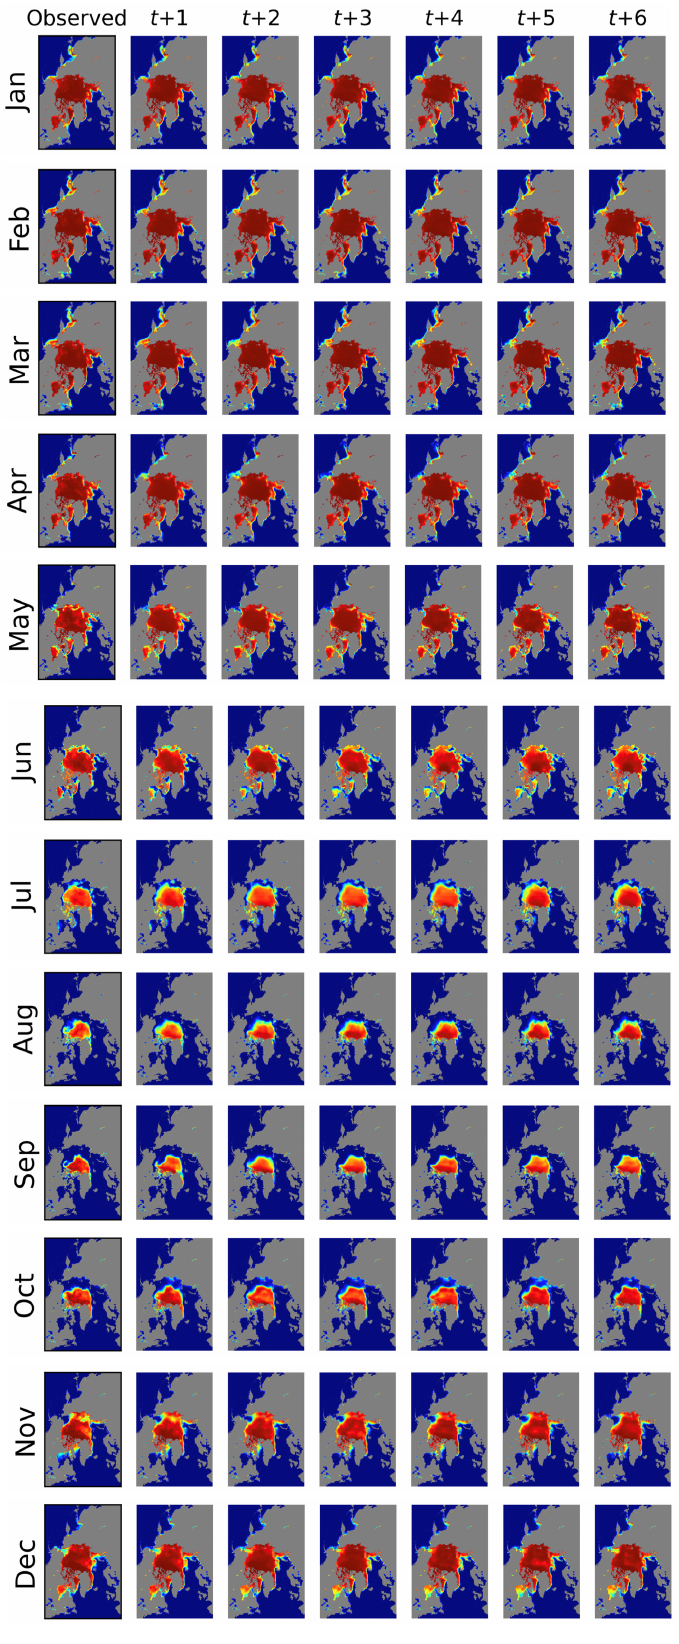
Figure 8. The predicted sea ice concentration images for 2020 based on lead-time and month.